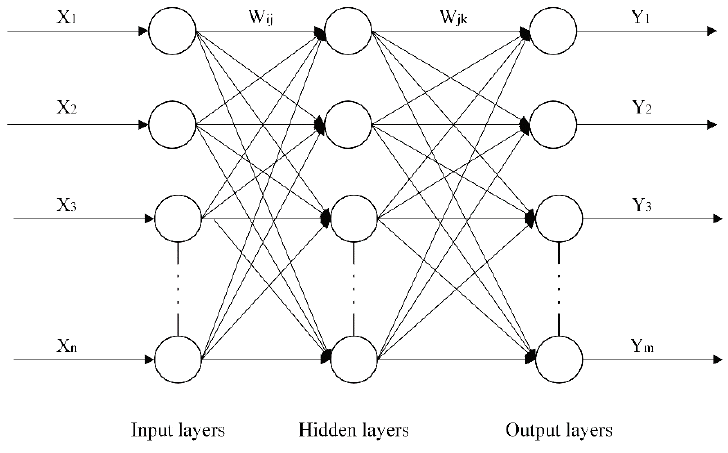
Figure A1. A typical artificial neural network.